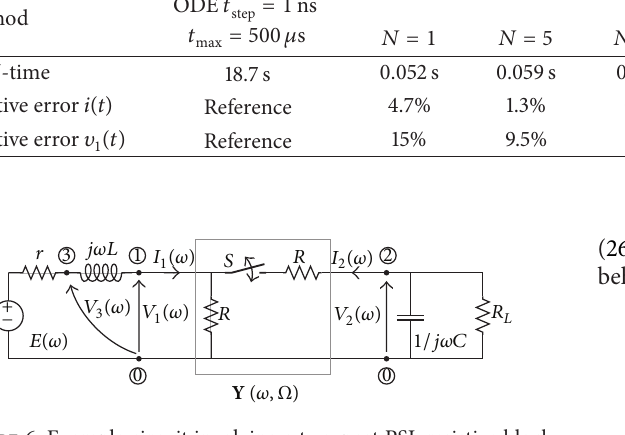
Table 1: CPU-time required by the simulation of the circuit of Figure 3 and accuracy of the computed current and voltage responses 𝑖(𝑡) and (𝑡) , for an increasing number of terms 𝑁 defining their truncated expansions (e.g., see (23)). 𝑣 1 Method